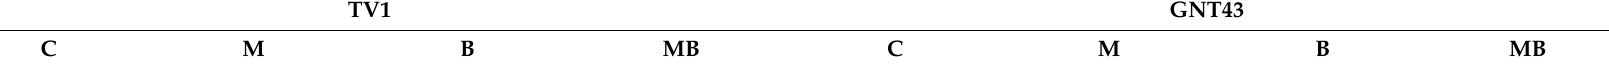
Table 1. The soil physicochemical characteristics on experimental